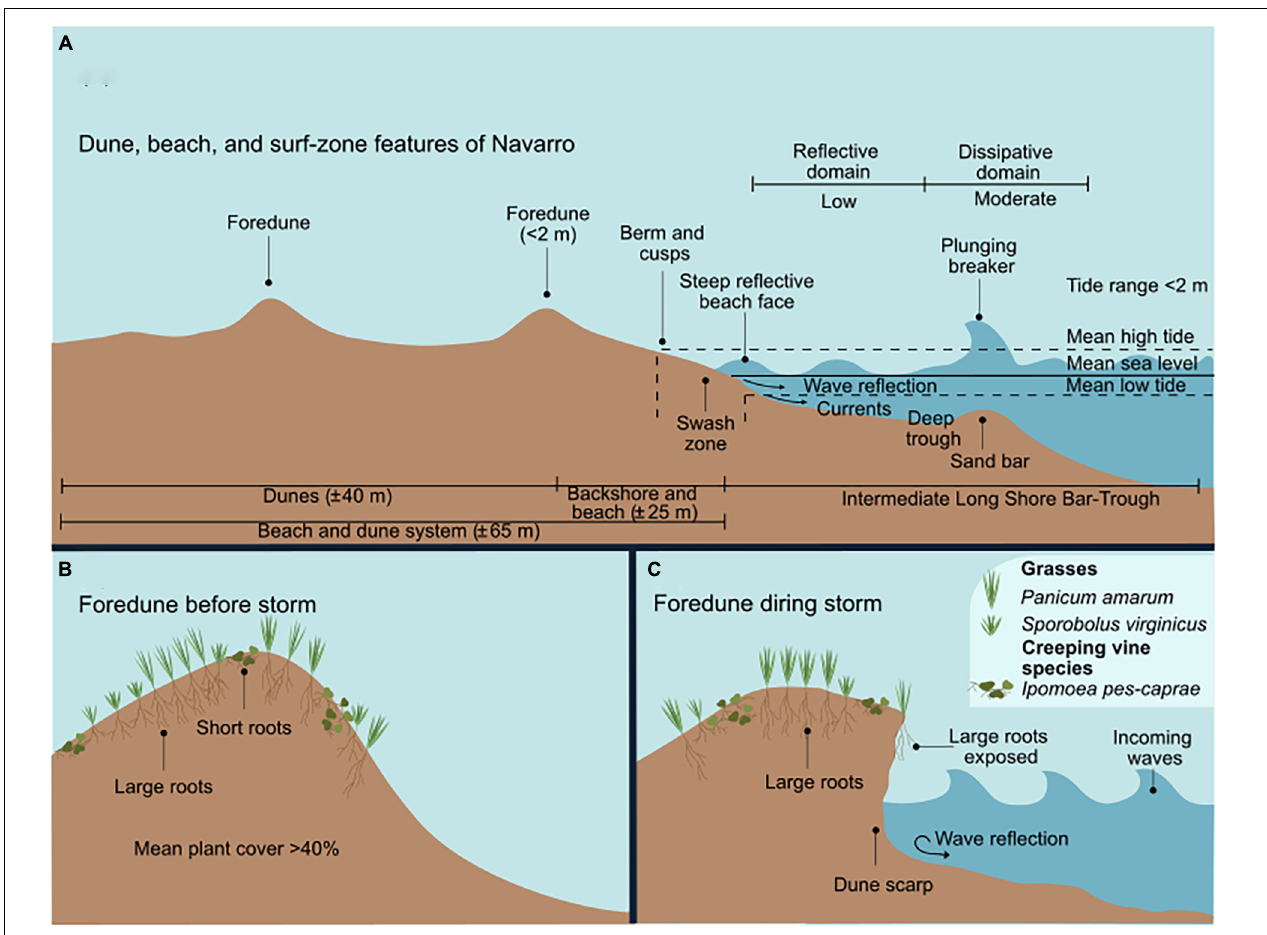
FIGURE 5 | The surf-zone and foredunes of Navarro. (A) Dune, beach, and surf-zone features. (B) The foredunes and species before the storm. (C) The foredunes during the storm, showing the wave-induced